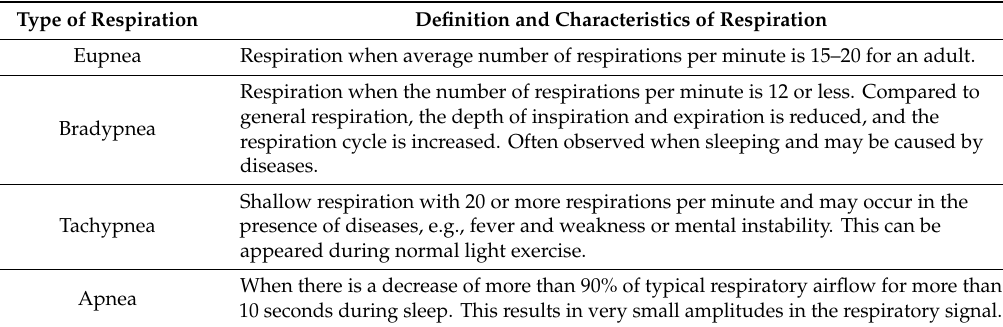
Table 2. Respiration type according to number of respirations per minute.